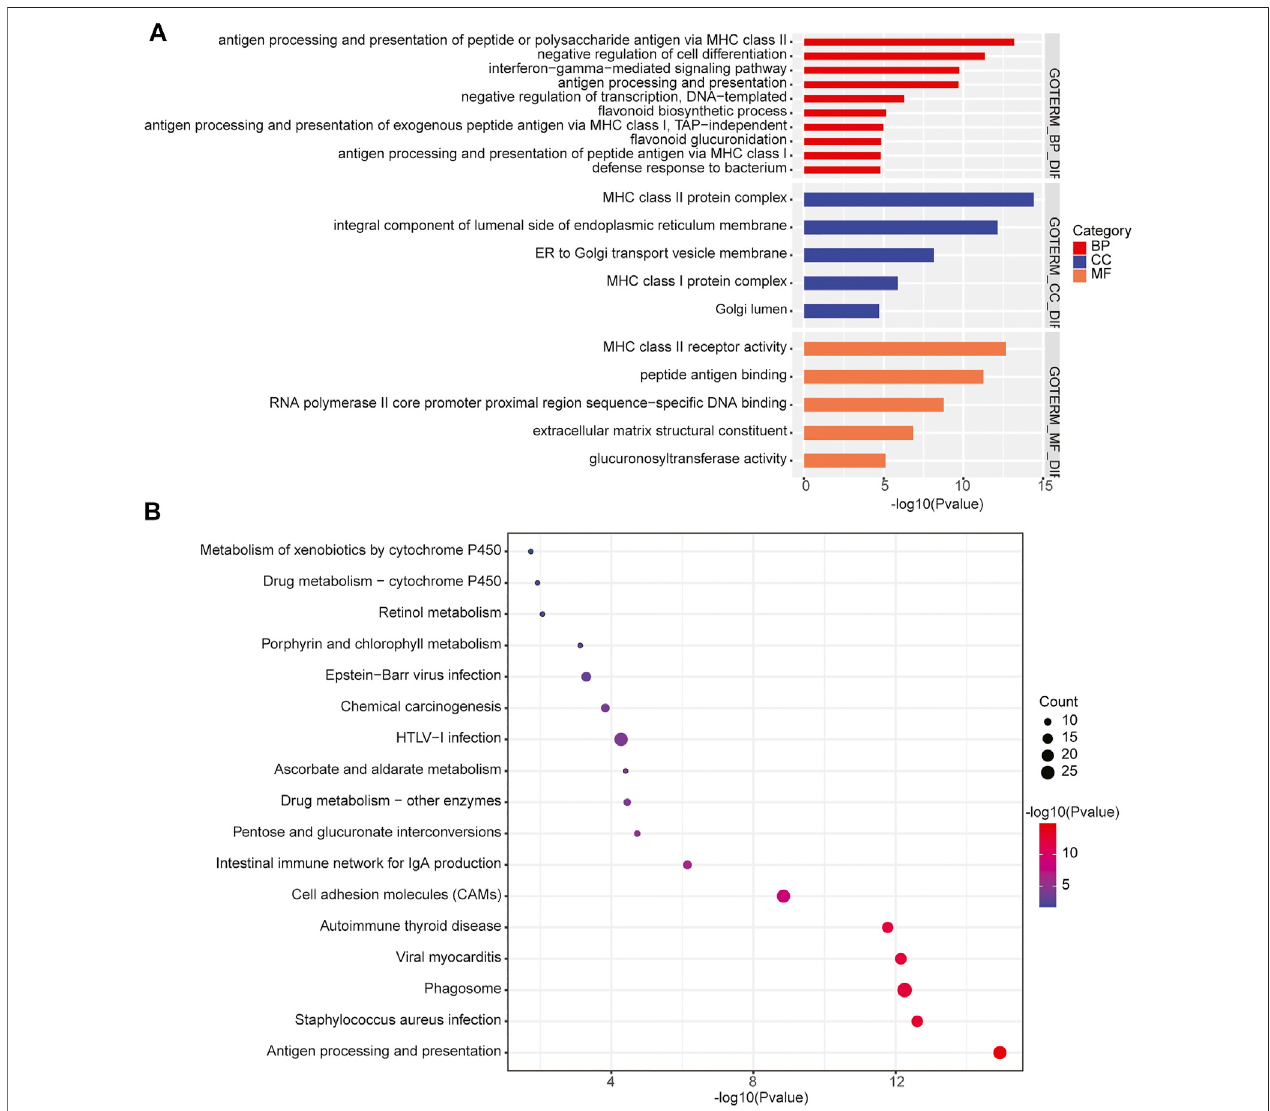
FIGURE 5 | Enrichment of the CNV-related genes identi fi ed in primary CNS DLBCL. (A) GO and (B) KEGG analysis of the enriched pathways of the 1,208 genes located in the detected CNV regions.